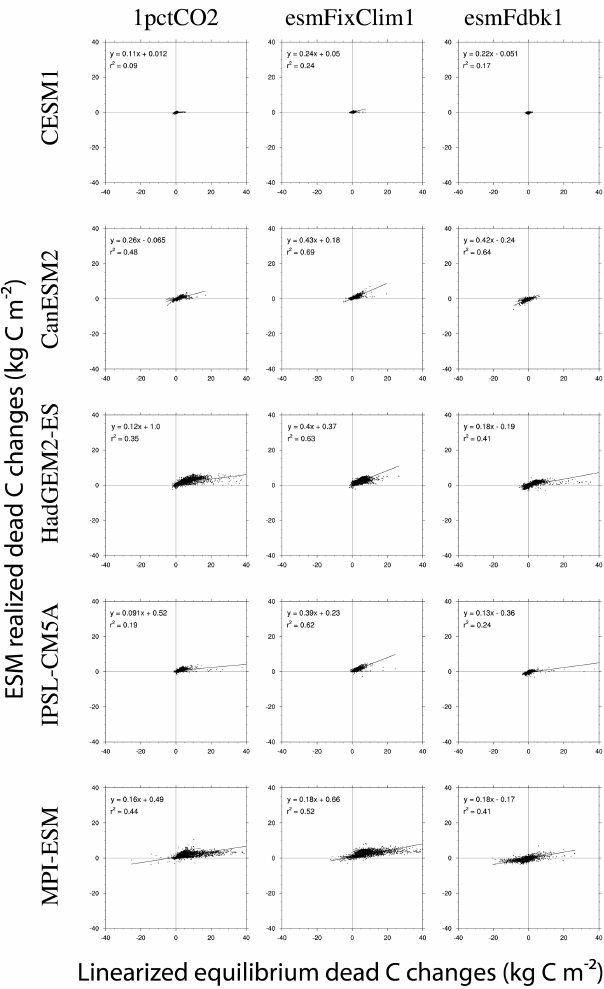
Figure 7. Scatterplots of linearized equilibrium dead carbon pool changes (Eq. 14) versus actual ESM-predicted realized dead carbon changes for each model and